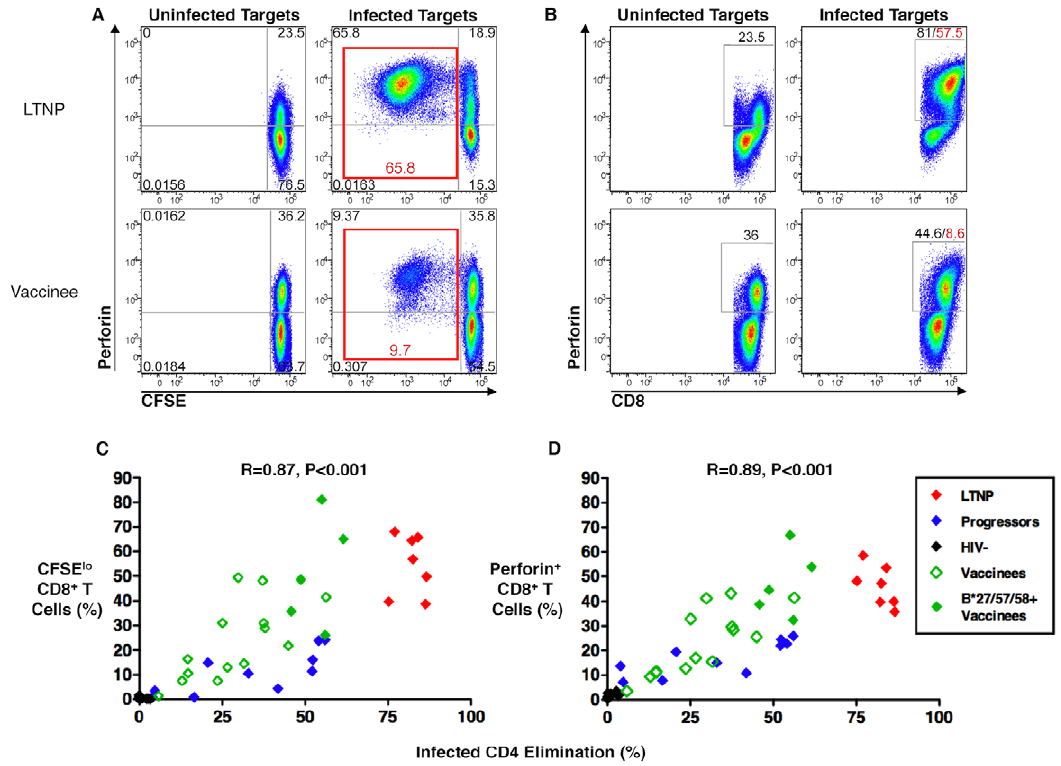
Figure 4. HIV-specific CD8 + T-cell proliferation and perforin expression correlated with cytotoxic capacity in recipients of an Ad5/ HIV vaccine. (A, B) Flow cytometry plots of a representative LTNP (top row) and Ad5/HIV vaccine recipient (bottom row) depicting CD8 + T-cell proliferation (A) and CD8 + T-cell perforin expression (B) following 6-day stimulation of CFSE-labeled PBMC with uninfected (left columns) or HIV SF162 - infected (right columns) autologous CD4 + T-cell targets. Plots are gated on CD8 + T-cells. Net HIV-specific CD8 + T-cell proliferation (sum of upper left and lower left quadrants in A, right column) and net CD8 + T-cell perforin expression (as determined by subtracting background perforin expression measured in cells that had been stimulated with uninfected targets; B, left column) are shown in red font. (C, D) Summary data of CD8 + T-cell proliferation (C) and perforin expression (D) are shown for LTNP (red symbols, n=7), progressors (blue symbols, n=10), HIV-negative individuals (black symbols, n=10) and Ad5/HIV vaccinees (green symbols, n=19), including 5 individuals carrying the protective HLA class I alleles B*27, B*57 or B*58 (solid green symbols). Data are representative of at least two experiments. Statistical analyses were performed using the Spearman correlation.